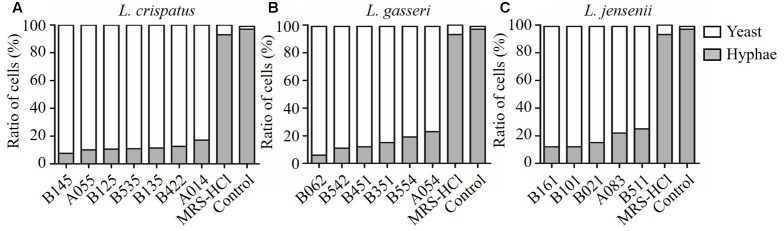
Inhibition effects of CFS from different Lactobacillus strains on C. albicans hyphal formation. (A)
L. crispatus, (B)
L. gasseri, (C)
L. jensenii. Effect of the addition of CFS on the yeast-to-hyphae conversion induced by liquid RPMI 1640 + 10% FBS medium at 37°C for 4 h in microtiter wells.